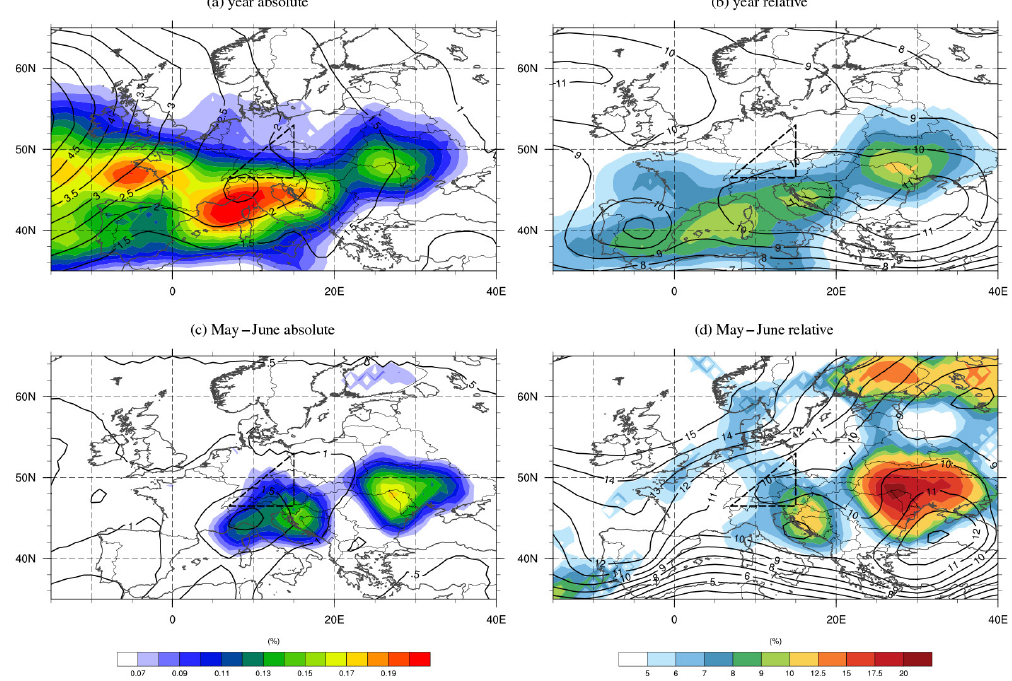
Figure 7. (a, c) : frequency of “equatorward ascending WCBs” (shaded every 0.01%) and total WCB frequency (contours every 0.5%). (b, d) relative frequency of “equatorward ascending WCBs” (shaded in % see colour bar) and cut-off frequency in the layer 305–330K (contours every 1.0%). In (a, b) the climatology for the entire 34year (1979–2012) ERA-Interim data set is shown. In (c, d) only the climatology for May–June is